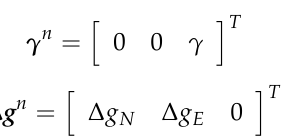
Figure 2. The definition of the navigation coordinate frame with true plumb line. ( a ) is the definition of navigation coordinate frame with true plumb line, ( b ) is the side view of ( a ).